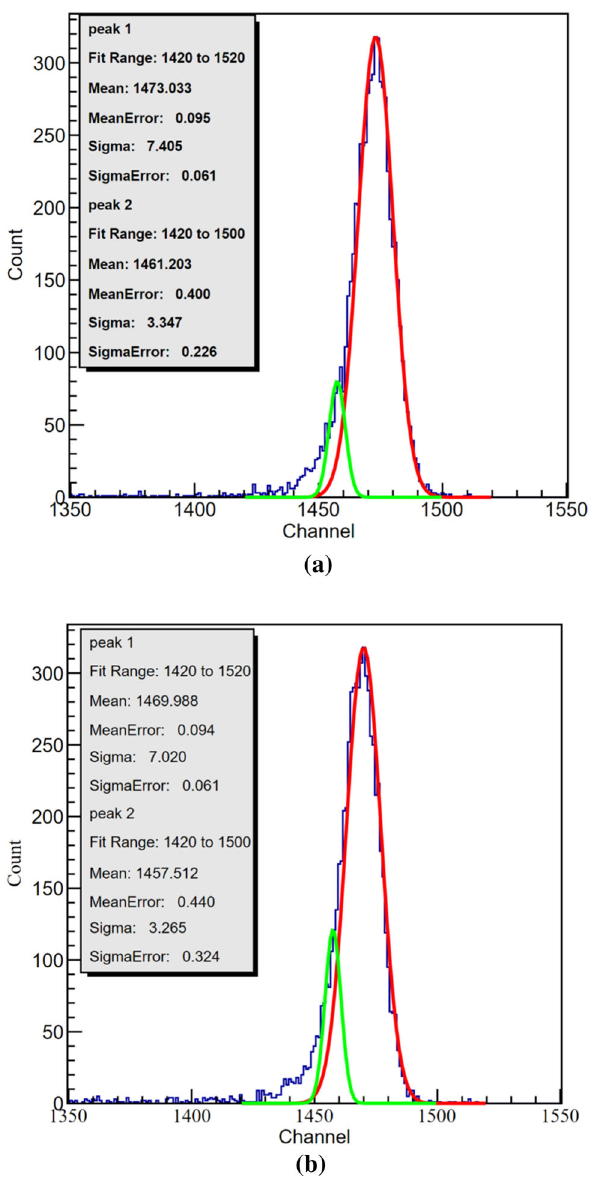
Fig. 6 Energy spectra obtained with an 241 Am source at 700 mbar for two different sealed windows of the ionization chamber: a DSA sealed windows, and b SSA sealed windows. The red lines (on top of the data) represent the total adjustment to the data taking into account the known alphapeakenergies(5.48556MeV)andbranchingratios(84.8%),while the green lines refer to the alpha peak energies (5.44428 MeV) and branching ratios (13.1%)